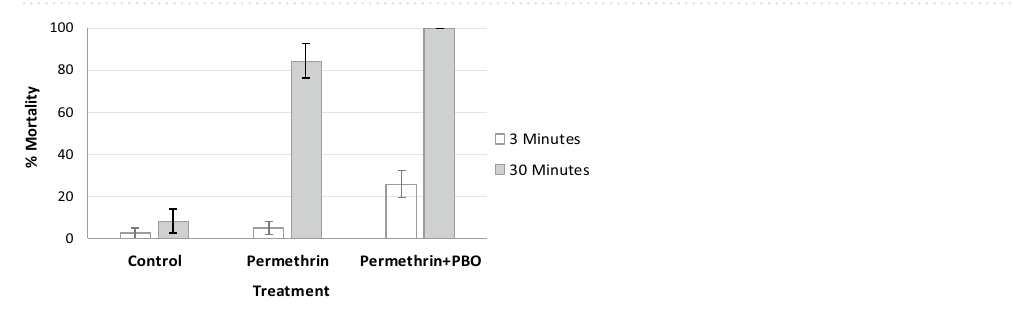
Figure 3. Mortality rates for susceptible strain for 3 min exposure versus 30 min exposure from different blanket treatments. Error bars are equivalent to 95% confidence